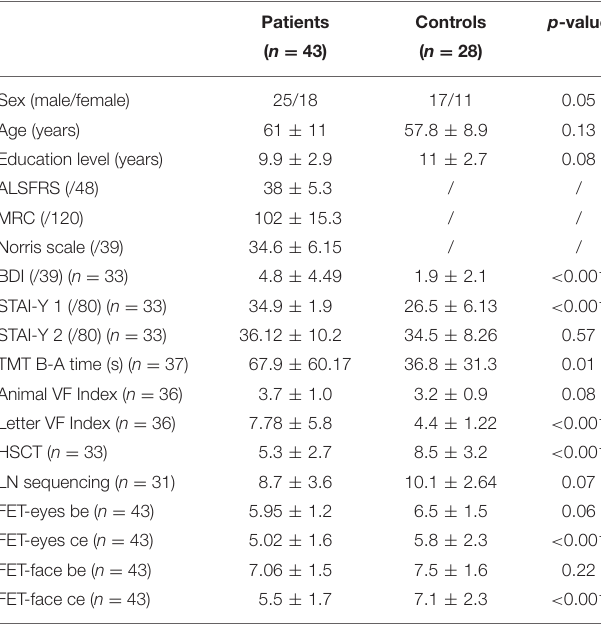
TABLE 2 | Comparison of baseline sociodemographic, neurological, cognitive and emotional characteristics between patients included and not included at follow-up. Patients included Patients not at included at follow-up ( n = 22)